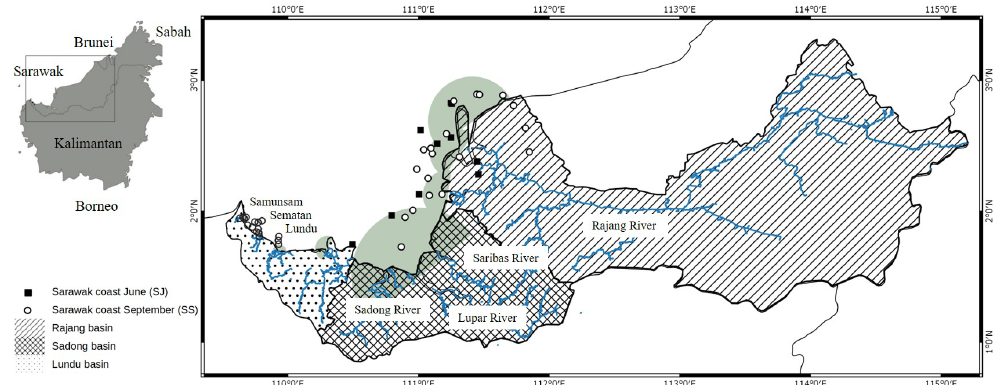
Figure 2. The map on the left shows Borneo Island, with the rectangle indicating the expanded map shown on the right. The map on the right shows the stations sampled in June and September 2017, with the Rajang, Sadong and Lundu basins indicated by different patterns. The grey semi-circles represent shape files used to retrieve maximum dissolved organic carbon (DOC) concentration from the river plume areas (excluding land area). Major rivers and tributaries for the respective basins are indicated with blue lines.